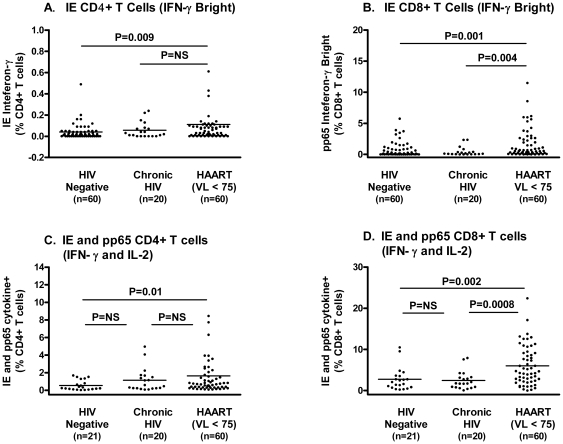
The distribution of the CMV-specific CD4+ and CD8+ T cell responses (background corrected) in three unique groups: (1) HIV-seronegative, CMV-seropositive, (2) established chronic untreated HIV infection, and (3) antiretroviral-treated infection with undetectable plasma HIV RNA levels.The IE IFN-γ-bright levels are shown in panel A (CD4+ T cells) and panel B (CD8+ T cells). The combined pp65 and IE IFN-γ/IL2 data are shown in panels C (CD4+ T cells) and panel D (CD8+ T cells). The data in panels C and D reflect the sum of all possible response (IFN-γ alone, IL2 alone, or IFN-γ/IL2) to each of the CMV proteins. Standard gating was used for dual cytokine data.